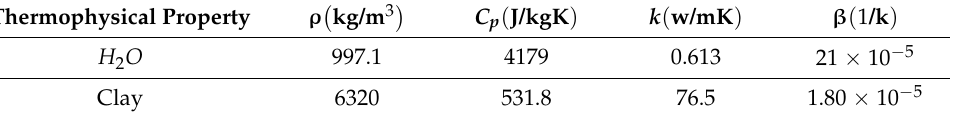
Figure 3. Variation of Gr in v .